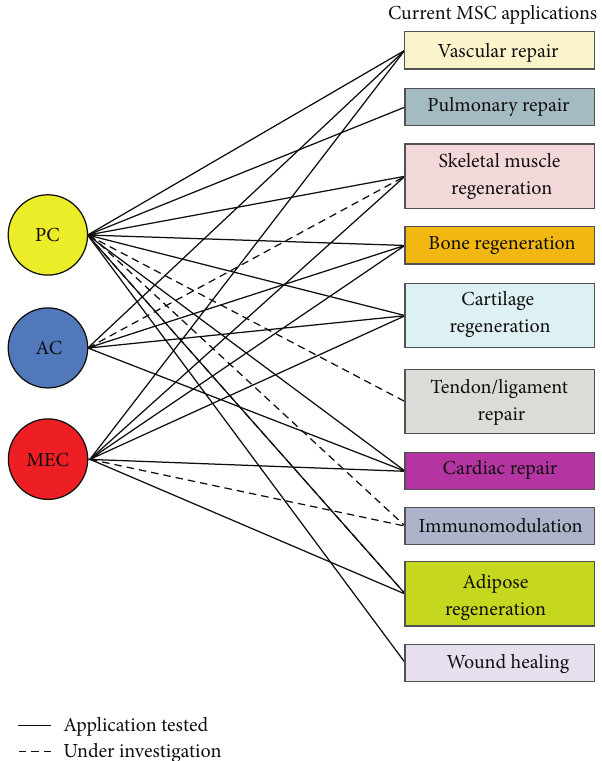
Figure 2: Potential translational applications of hBVSC subpopu- lations. The current translational applications of typical MSCs are summarizedontheright.Thecurrentstatusoftranslationalresearch for each hBVSC subset is outlined, whether the specific application has been tested or is presently under